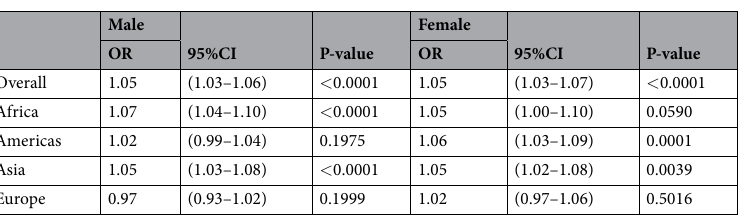
Table 4. Sex-stratified association between perceived stress and smoking (outcome) estimated by multivariable logistic regression. Abbreviation: OR odds ratio; CI confidence interval The perceived stress score ranged from 2–10 with higher scores corresponding to higher levels of perceived stress. Models are adjusted for age, wealth, setting, and